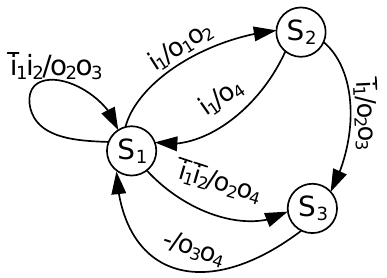
Figure 1. State transition graph of Mealy FSM Ex1.